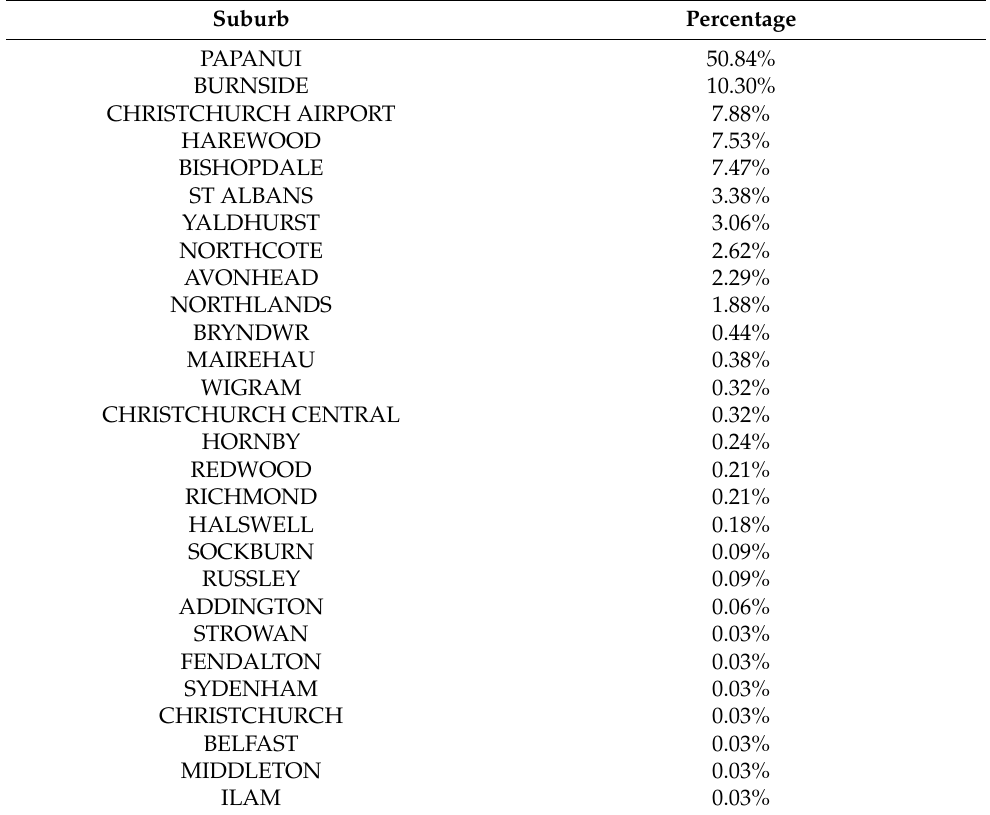
Table 2. One-year consignment data for the truck. Data sourced from the industry